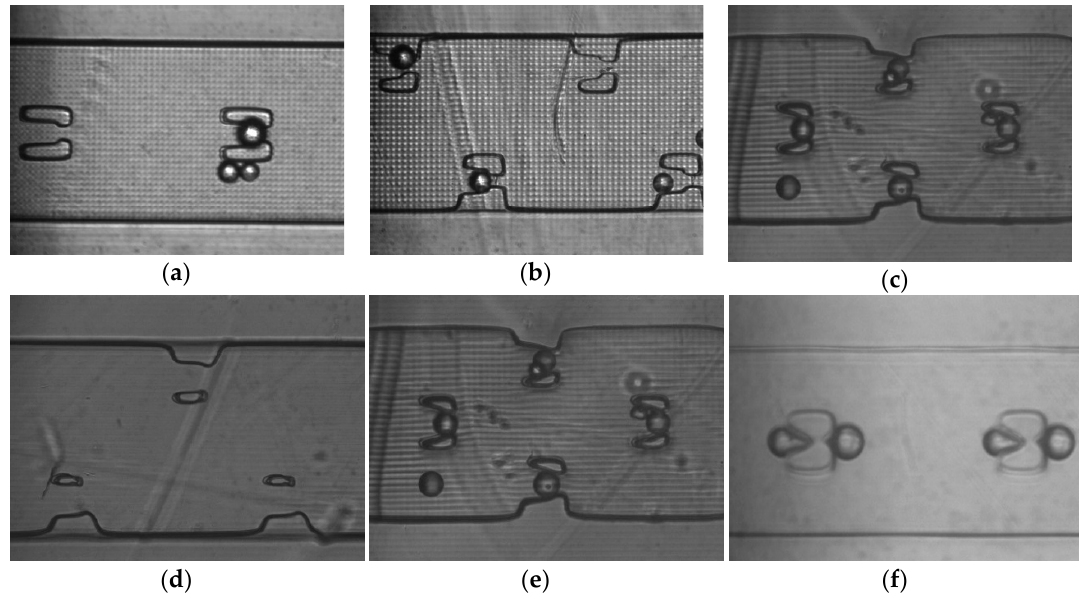
Figure 4. CCD images showing the effect of trap placement and different exposure times on trap shape. ( a ) Channel with traps exclusively in the center; ( b ) Channel with traps staggered along the sides; ( c ) Channel with traps staggered along the sides and in the middle of the channel; ( d ) Prints exposed 500 ms showing partially formed traps with no bead capture; ( e ) Prints exposed for 750 ms with beads trapped well; ( f ) Prints exposed at 1000 ms showing overexposed traps. Bubbles are stuck at the front and back of the traps hindering bead capture.